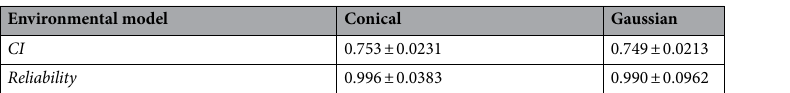
Table 1. Chemotaxis performance of the successful model elegans sub-population in two environmental models ( n = 108, ±